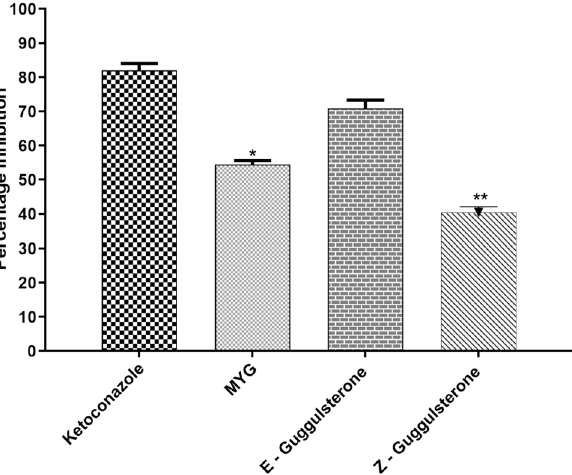
Figure 2. Percentage inhibition of MYG and guggulsterone isomers versus ketoconazole. Values are expressed in mean ± SEM; n = 3; ANOVA followed by Dunnett’s multiple comparison Test. Level of significance at * P < 0.05, P <